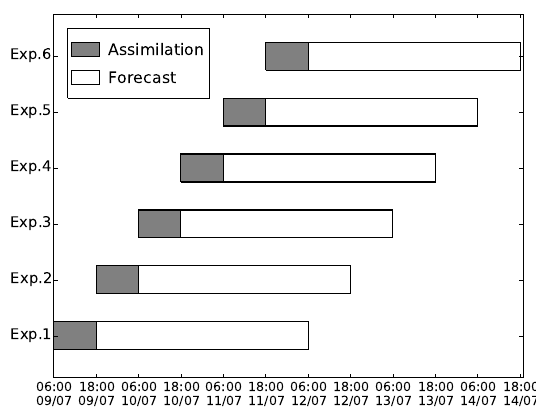
Figure 8. Schematic representation of six DA experiments with a 12h assimilation period (grey colour) and a 60h forecast period (white colour). Exp. stands for DA experiment.